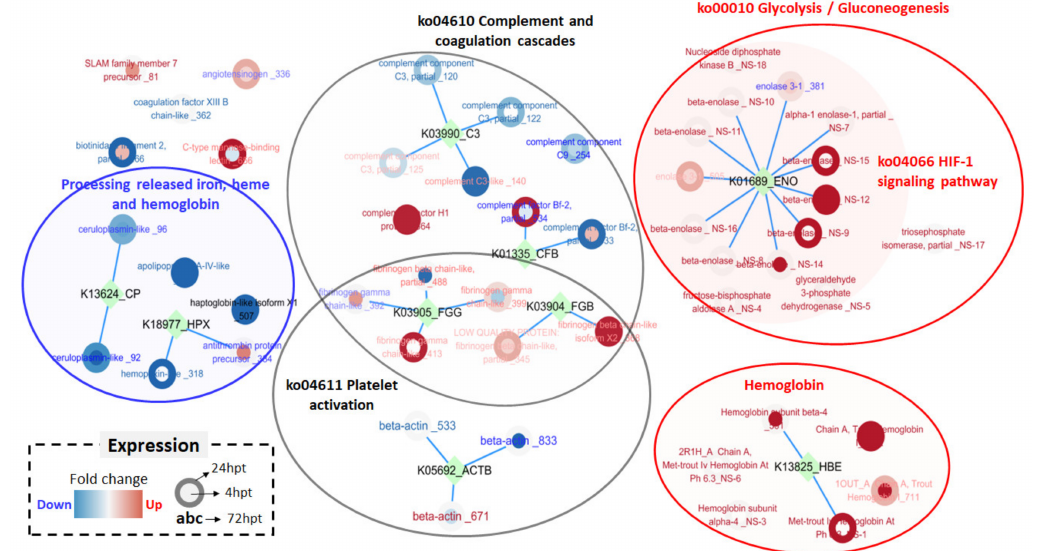
Figure 7. Di ff erentially expressed protein (DEP) expression in the plasma of rainbow trout exposed to thermal stress. The thickness of the red or blue circle, edge, and letters indicates the magnitude of higher or lower expression respectively, at 4, 24, and 72 hpt compared to control. The DEPs were clustered by ko_id with glycolysis / glyconeogenesis, hypoxia-inducible factor 1 (HIF-1) signaling pathway, hemoglobin, platelet activation, complement and coagulation cascades, and processing of released iron, heme, and